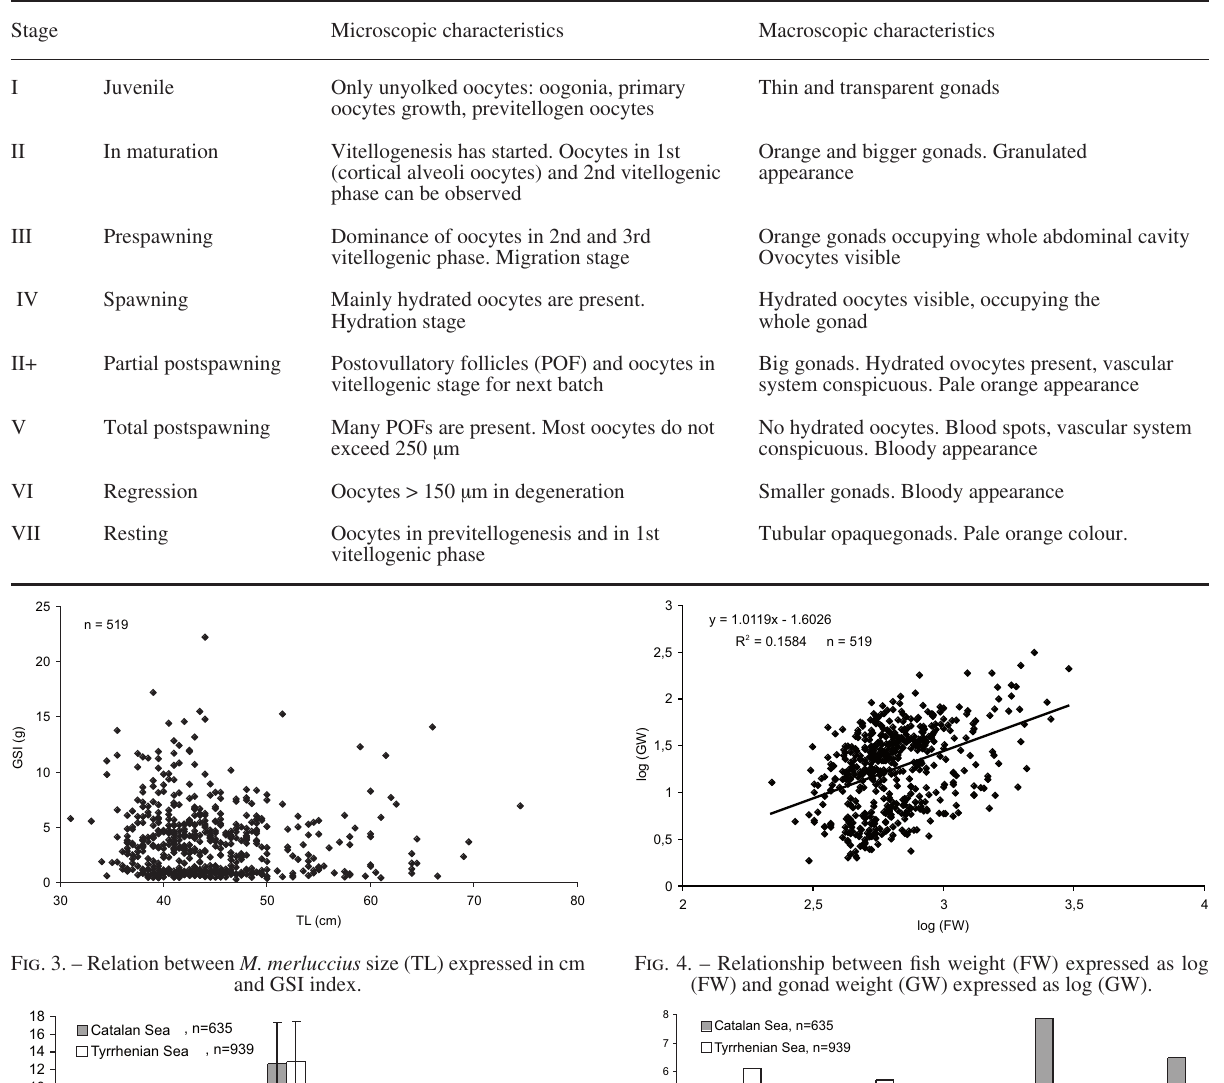
Table 3. – Correspondence between microscopic and macroscopic maturity ovary staging characteristics.